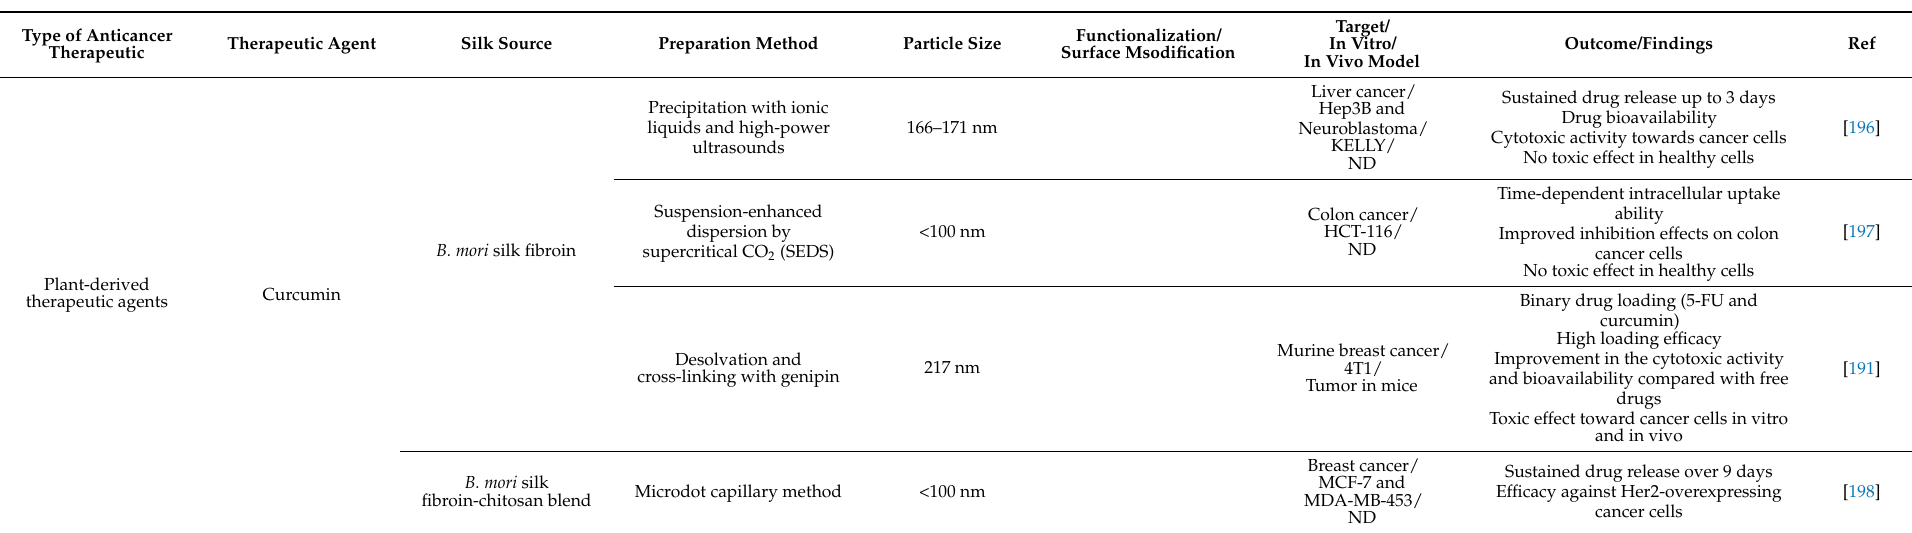
Table 3. Delivery of anticancer therapeutic agents using silk-based